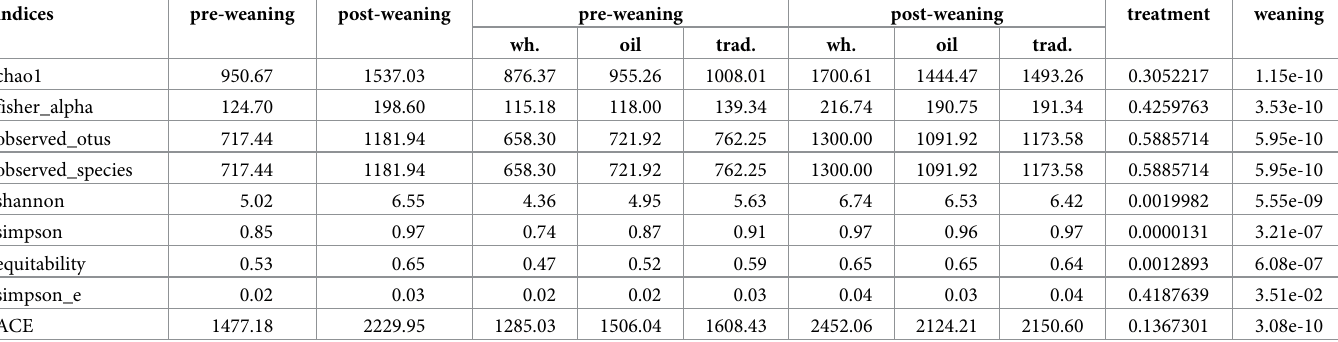
Table 5. Alpha diversity indices and significance of differences between treatments, timepoints and their interaction. indices pre-weaning post-weaning post-weaning